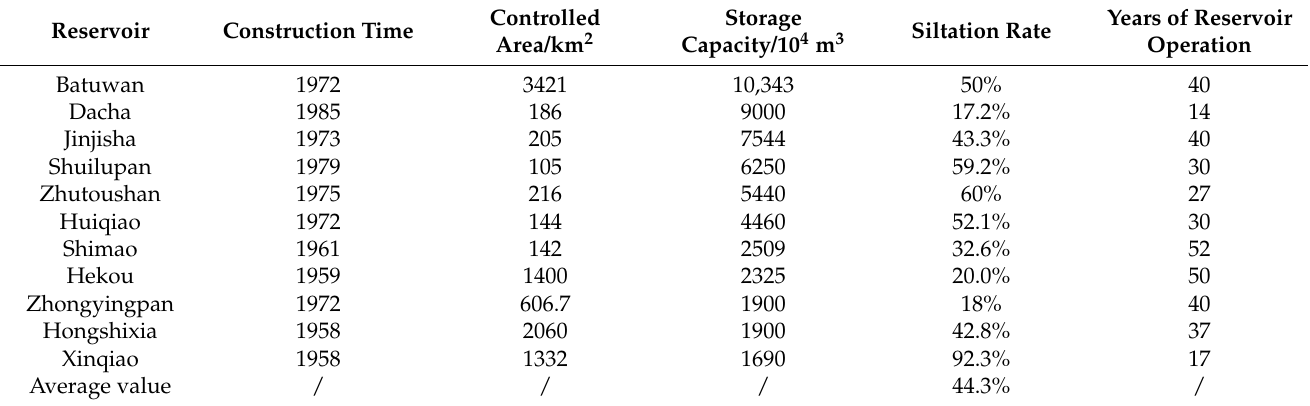
Table 5. Construction and siltation of the main reservoirs in the Wuding River